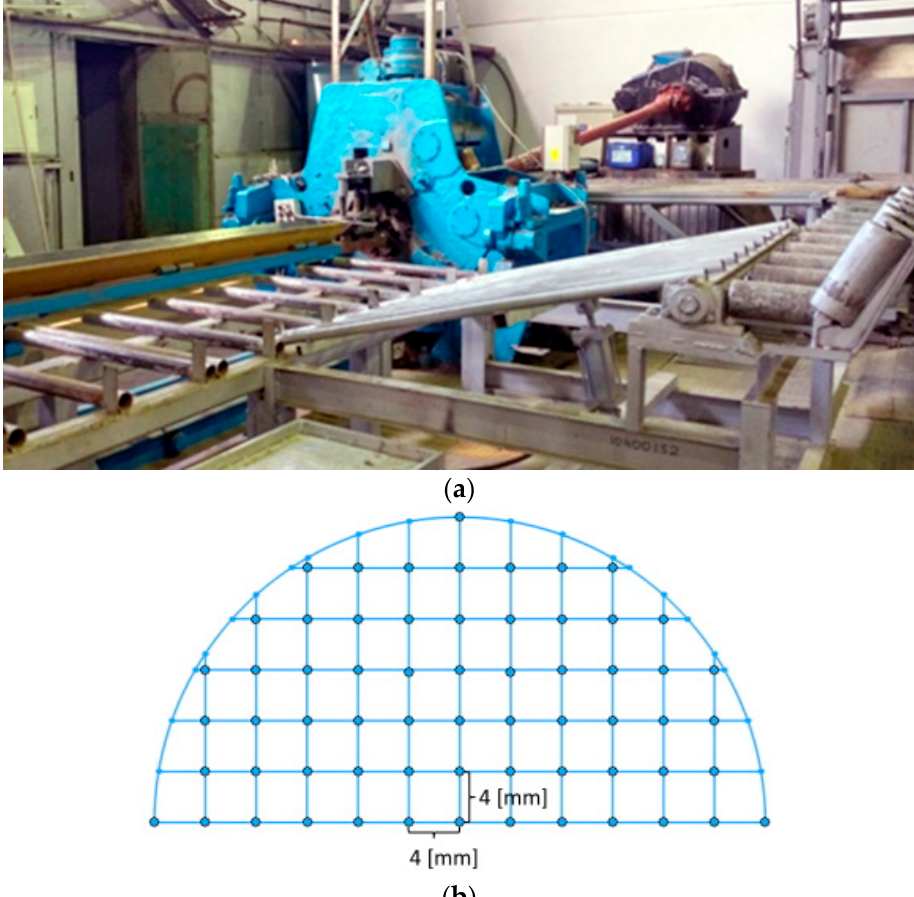
Figure 4. MISIS-100T mill ( a ) and visual field location scheme for the metallographic analysis of the cross section ( b ).